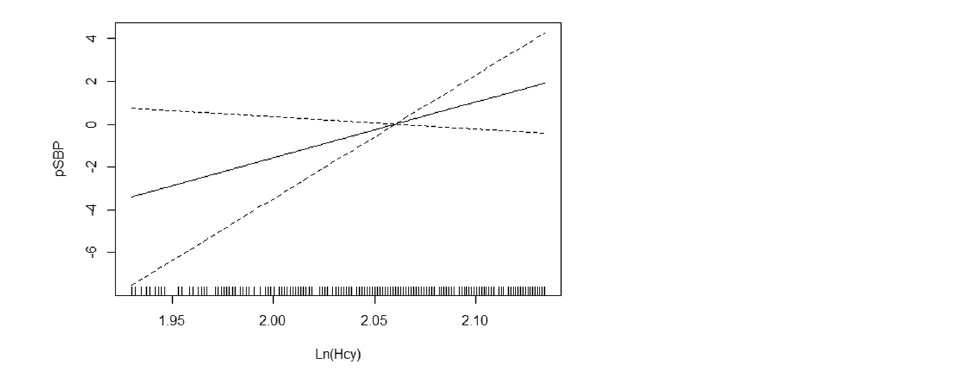
Figure 1. Smoothing curve of cSBP by lnHcy. Adjusted: age, sex, body mass index, smoking status, drinking status, serum creatinine, diabetes mellitus, dyslipidemia, cardiovascular disease, antihypertension drug use.